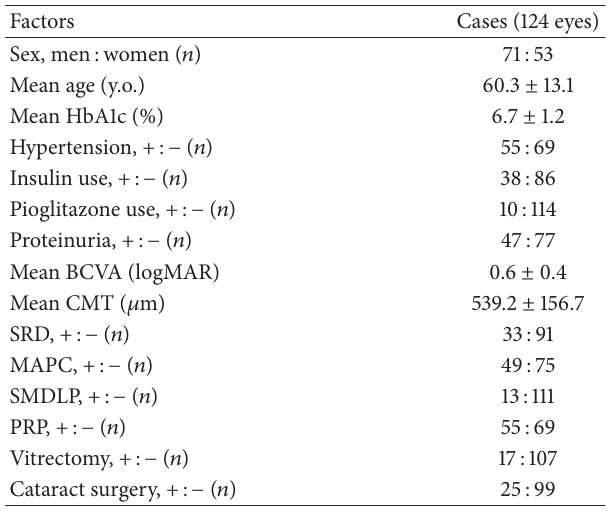
Table 1: Baseline clinical characteristics of 124 patients with DME.